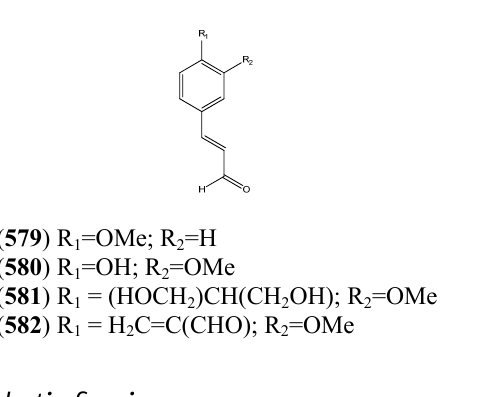
Figure 4. Metabolites which have been isolated from tissue culture of A.annua , but which have not yet been reported from A. annua plants.